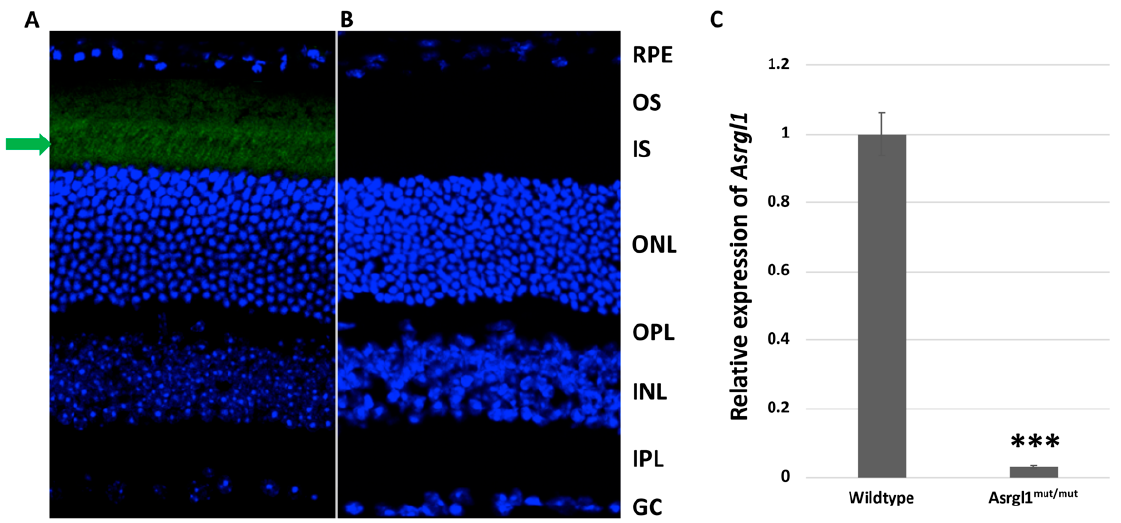
Figure 4. Expression profile of ASRLG1 in Asrgl1 mut/mu t mouse retina. ( A ) Immunostaining of retinal sections of 8-month-old wildtype mice detected positive staining of ASRGL1 in the photoreceptor layer. ( B ) Age-matched Asrgl1 mut/mut mice did not show staining of ASRGL1 in the photoreceptor layer. ASRGL1 (green) is stained with specific antibodies, and nuclei are stained with DAPI (blue). RPE: retinal pigment epithelium; OS: outer segments; ONL: outer nuclear layer; OPL: outer plexiform layer; INL: inner nuclear layer; IPL: inner plexiform layer; GC: ganglion cell layer. ( C ) Bar diagram showing Asrgl1 transcript levels in retinal sections of 3-month-old Asrgl1 mut/mut mutant and wildtype mice. The p value < 0.001 is indicated with ***.